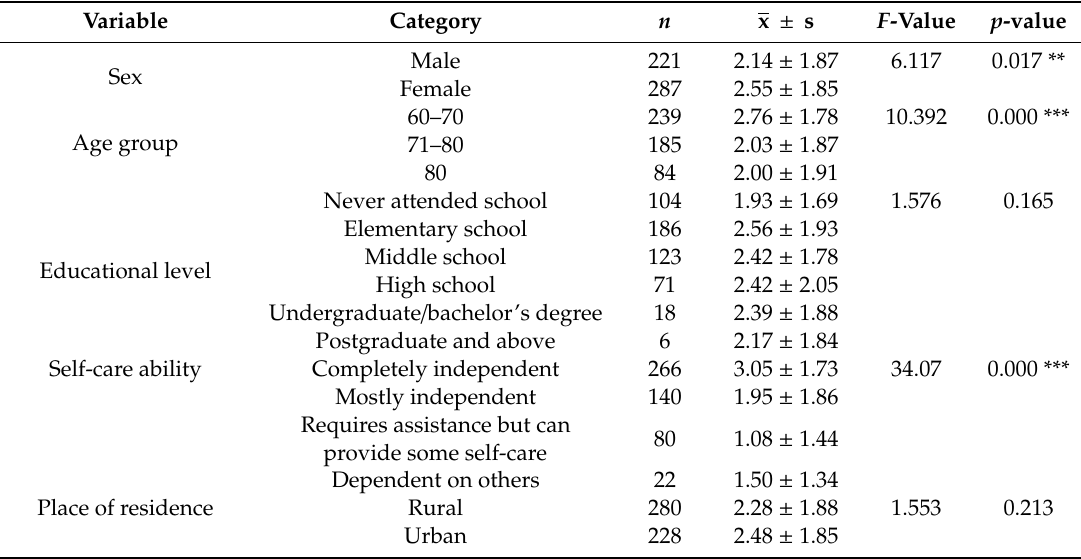
Table 5. One-way analysis of variance (ANOVA) ( x ± s ).